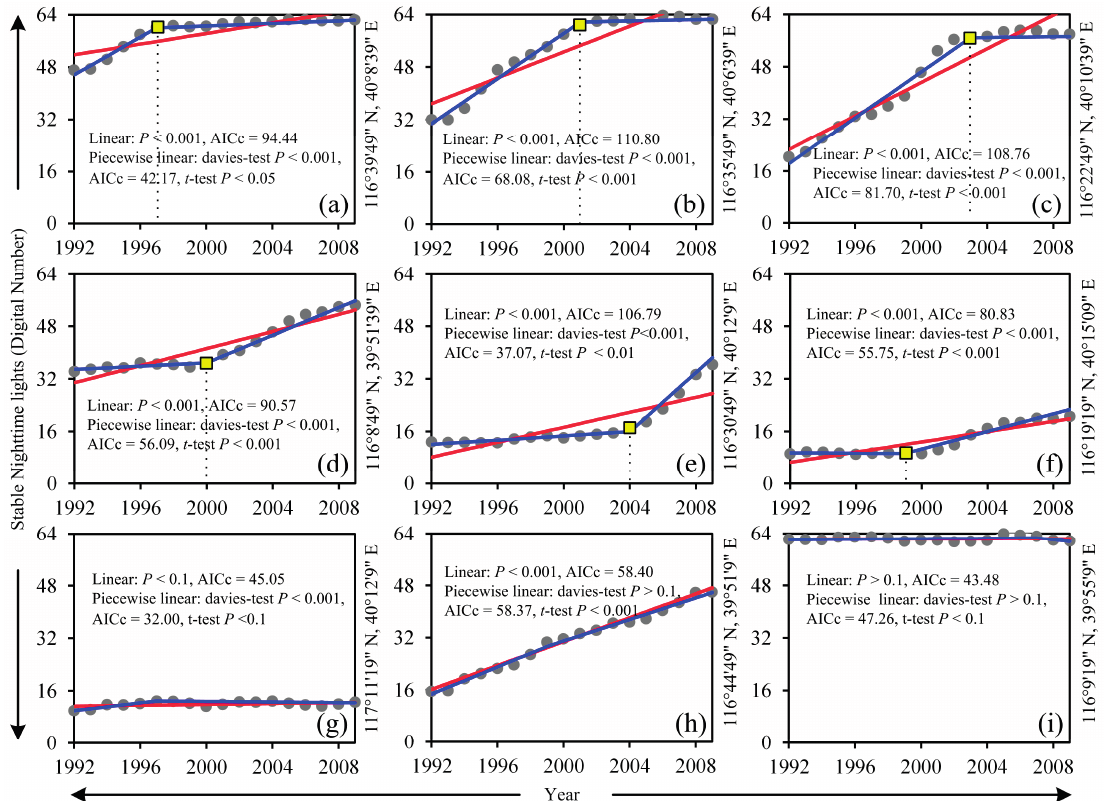
Figure 3. Typical samples of trends of stable nighttime lights at pixel level from 1992 to 2009. Two regression model are fitted: linear model (Red) and piecewise linear model (Blue). Yellow square represent the turning points of piecewise linear model. The p -value, davies-test, AICc and t -test are calculated to identify best-fitting model for each pixel. Six samples are identified as piecewise linear model ( a – f ), while three samples are identified as linear model ( g – i